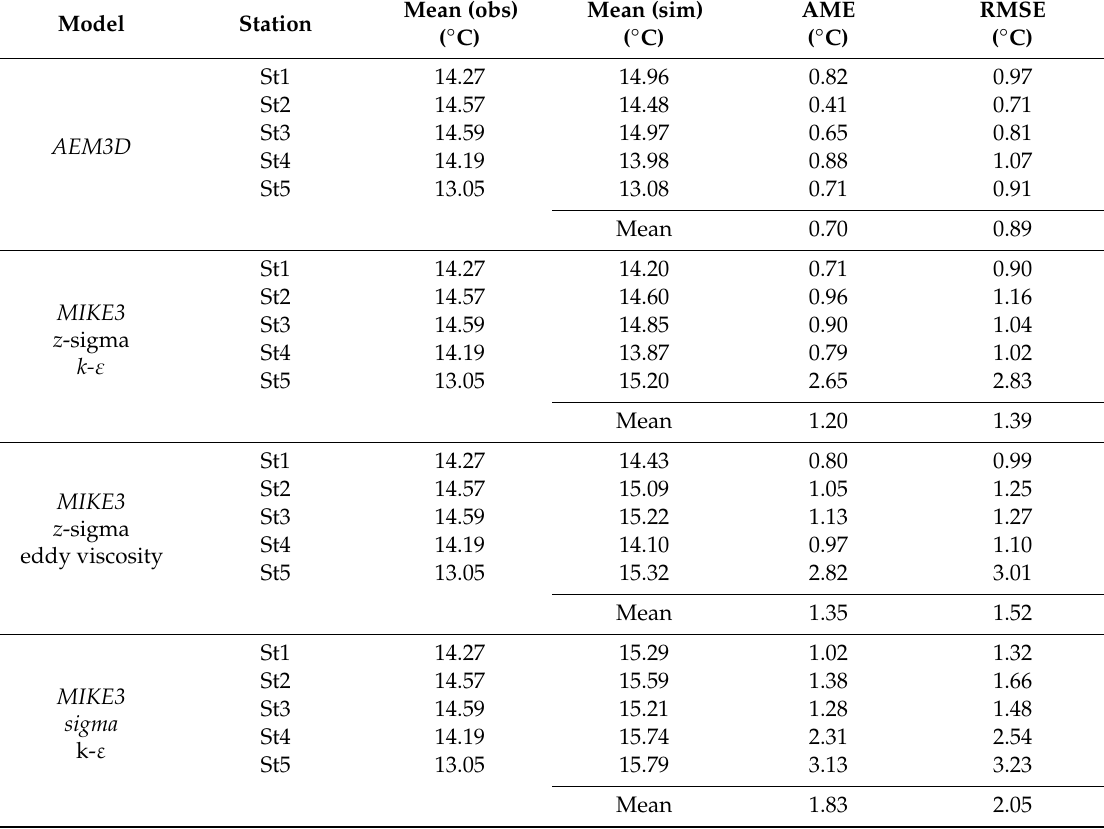
Table 3. Statistical results of AEM3D and MIKE3 (with di ff erent grid and v ertical mixing models).